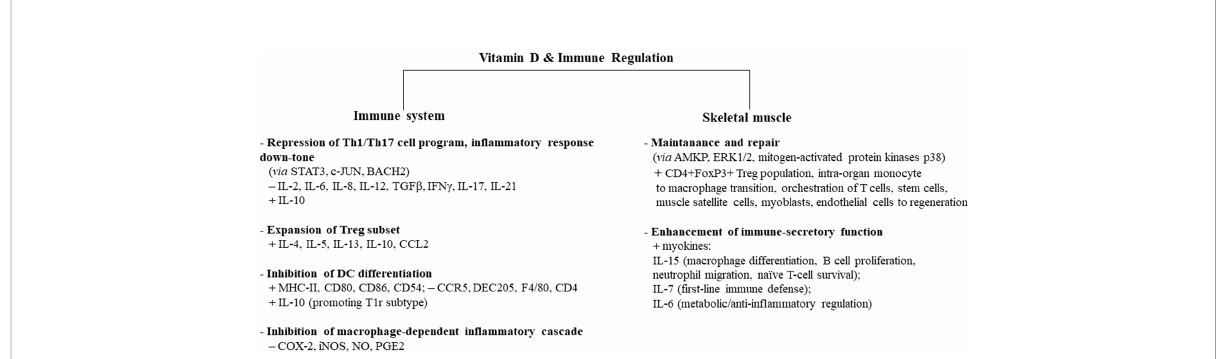
FIGURE 1 Vitamin D-induced immune regulation of the immune system and skeletal muscle. Vitamin D controls in fl ammation and promotes tolerogenic status, acting on several types of circulating immune cells, skeletal muscle cells, and intraorgan immune cells. Some cell types, biomediators, and signaling paths/molecules mainly involved in this process are indicated. Similar immune regulatory mechanisms are promoted by moderate exercise, while intense/prolonged exercise leads to a decline in immune surveillance, recalling the immunodepression allowed by sedentary status. Adequate vitamin D levels can downtone exercise-induced in fl ammatory-like response and converge to exercise-induced immunosurveillance boosting, with protective effects on whole-body health. Overtraining athletes in hypovitaminosis D can be at higher risk of infectious and noninfectious diseases. The signs “ + ” and “ − ” indicate up- and downregulation, respectively. AMPK, 5 ′ adenosine monophosphate-activated protein kinase; ERK1/2, extracellular signal-regulated kinase 1/2; Tr1, type 1 T regulatory cells; MHC-II, major histocompatibility complex II; STAT3, signal transducer and activator of transcription 3; c-JUN, transcription factor Jun; BACH2, transcription regulator protein broad complex-tramtrack-bric a brac and Cap'n'collar homology 2; COX-2, cyclooxygenase 2; iNOS, inducible nitric oxide synthase; NO, nitric oxide; PGE2, prostaglandin